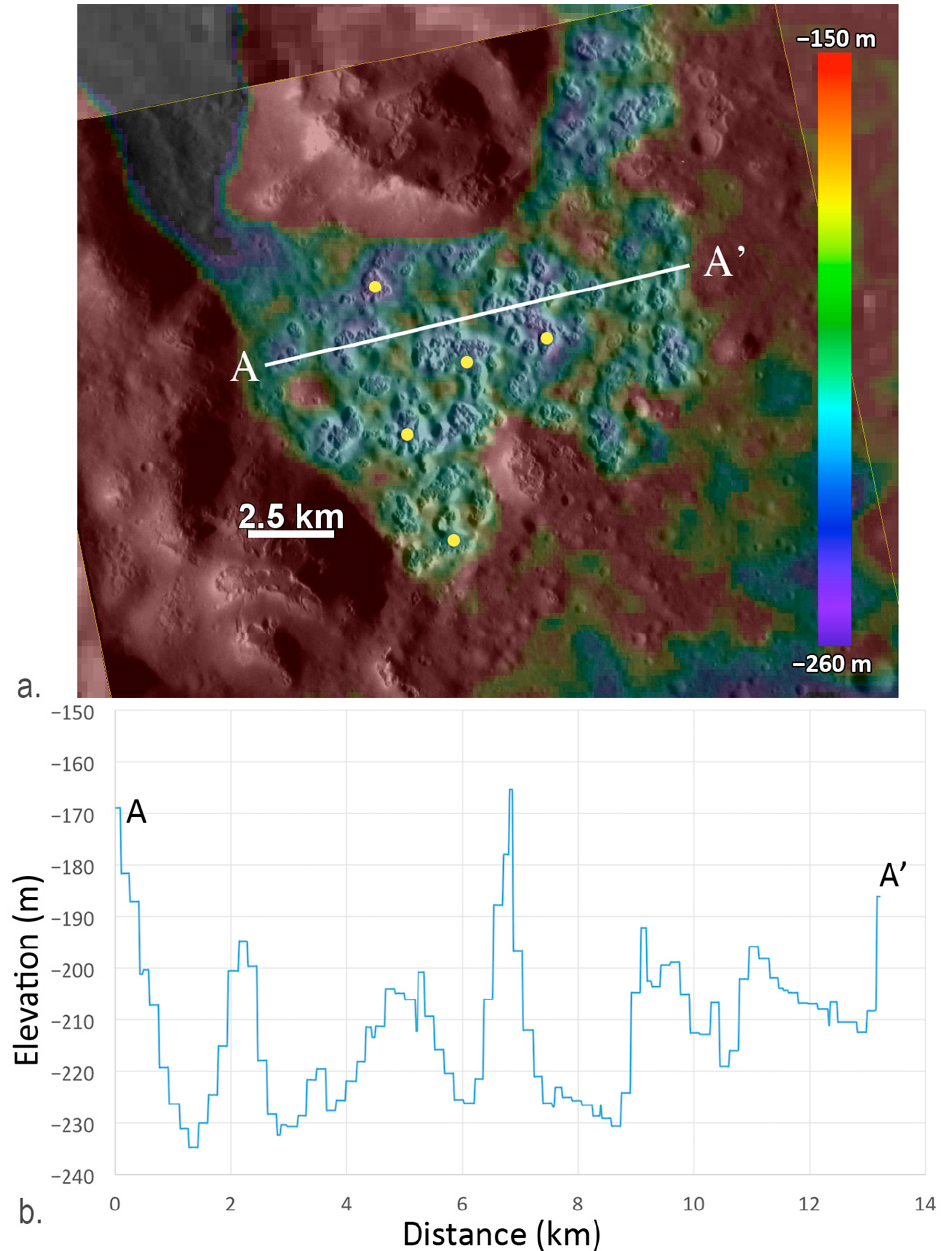
Figure 13. ( a ) Hollows along the peak ring of Raditladi Basin in color-shaded elevation map overlaid on associated orthophoto mosaic. The white line (A–A’) indicates the extent of the profile taken across the hollowed region. Yellow dots indicate five individual hollows measured for this study. See Appendix A for stereo details. ( b ) Elevation profile.